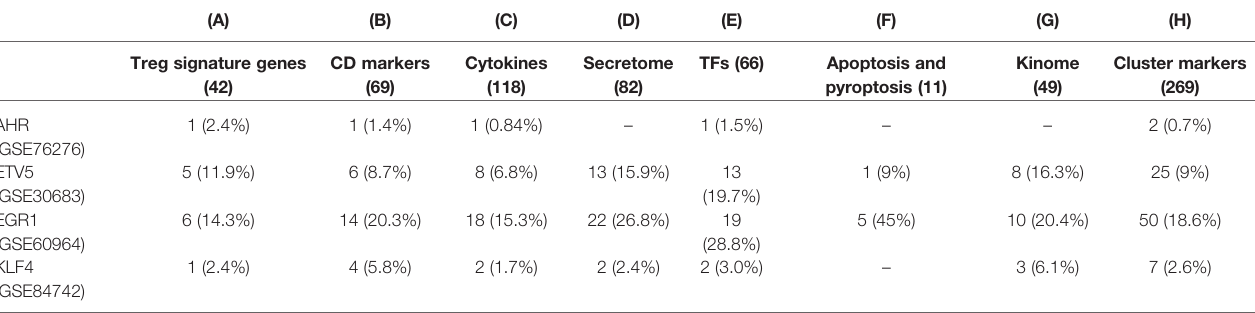
De fi ciency ordecreased levelsoffourtranscription factors in Table 14 (AHR,ETV5, EGR1, ANDKLF4)can reversethe expressionsofupregulated Treggenes infourtissues(SP,LN, INT, VAT) into downregulation of some Treg genes (the high percentages for each TF were highlighted in red). De fi ciency or decreased levels offour transcription factors are from